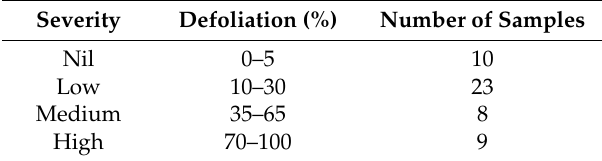
Table 2. Selected UAV sample images for calibration in each category of defoliation